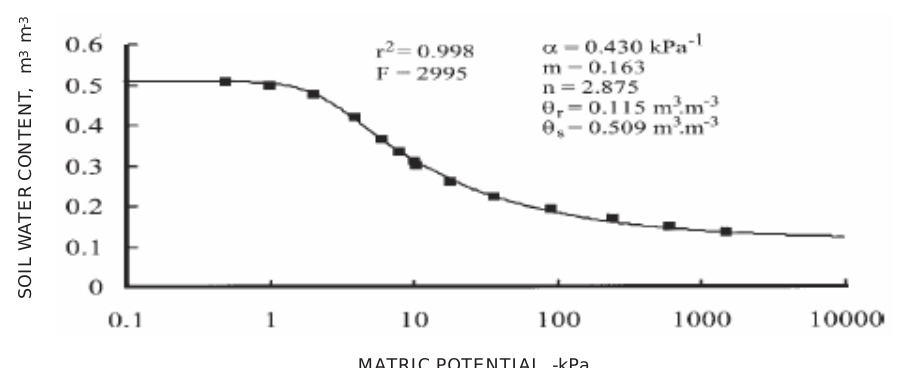
Figure 3. Soil water retention curve with experimental data and fitted